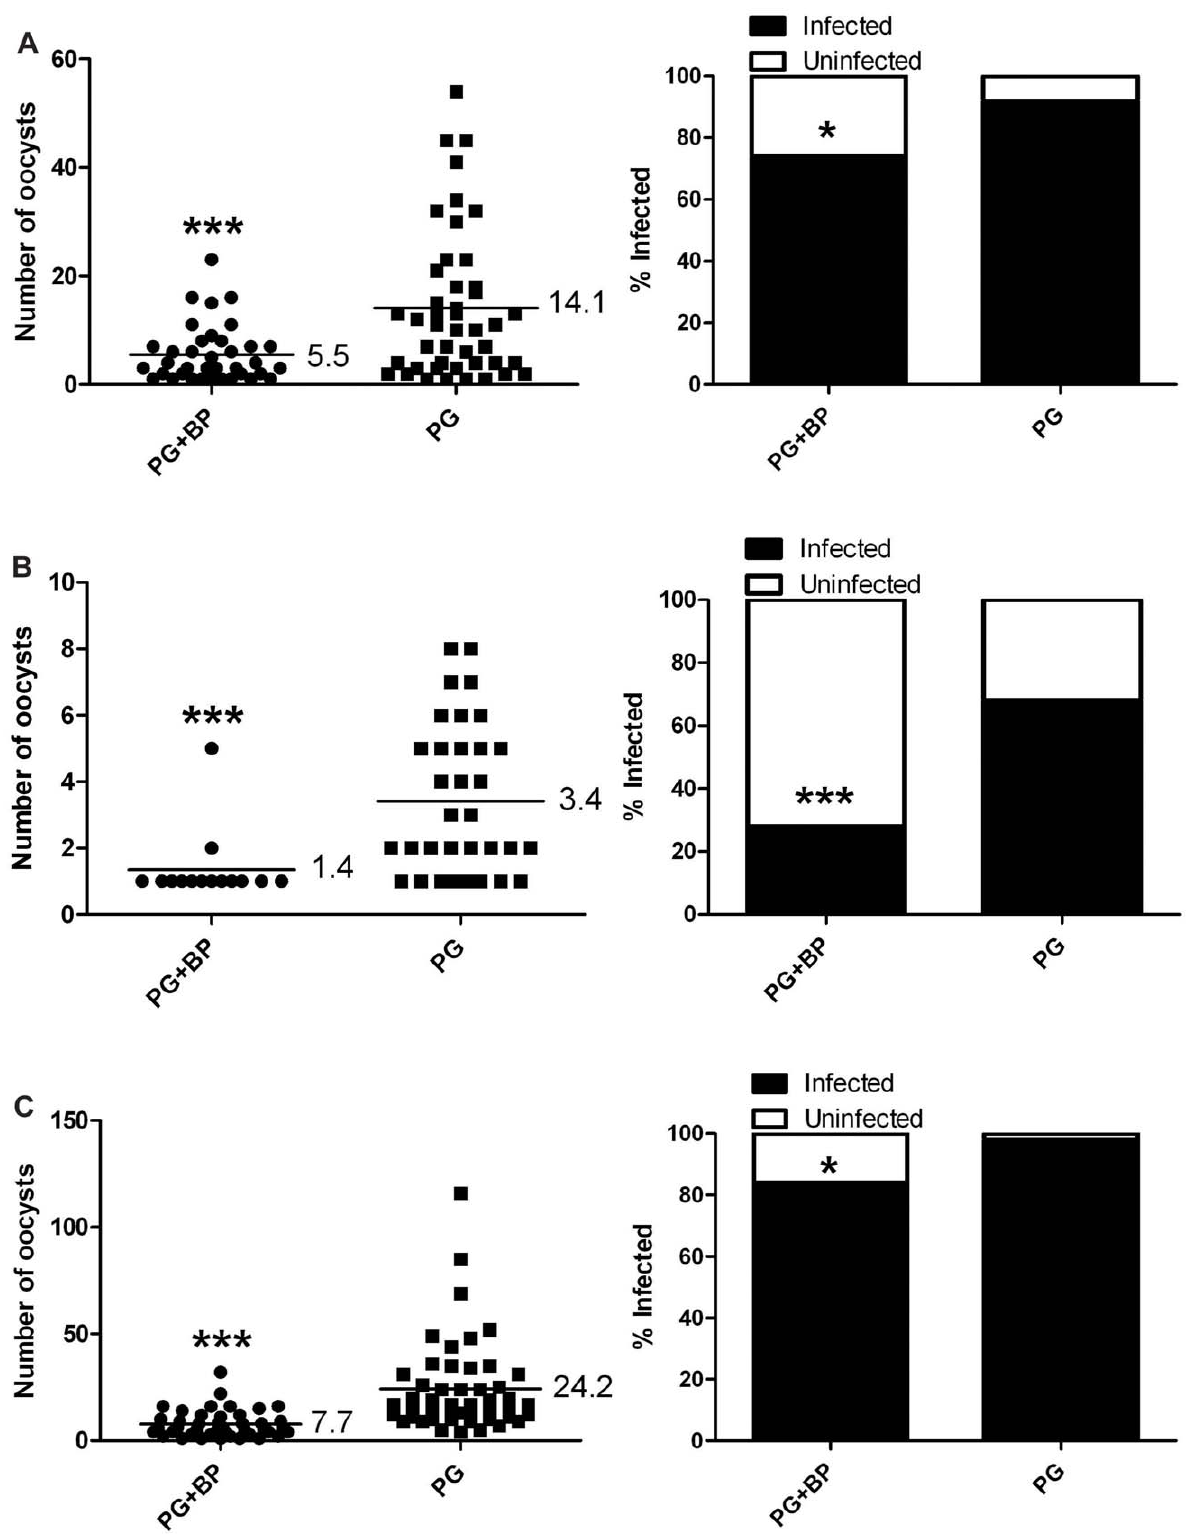
Figure 7. Plasmodium infection in Ae.aegypti that concurrently ingested P.gallinaceum and B.pahangi. Mosquitoes that fed on blood containing P. gallinaceum alone served as controls. For all, the left panel indicates infection intensity where points indicate the absolute value of oocyst counts in individual mosquitoes, and horizontal black bars represent the mean intensity. The right panel indicates prevalence of infection where the bars represent the total population of mosquitoes examined. The filled portion of the bars indicates the proportion of mosquito midguts that were positive for at least one oocyst; the unfilled portion of the bar indicates the proportion of midguts that were uninfected. PG, P. gallinaceum ;